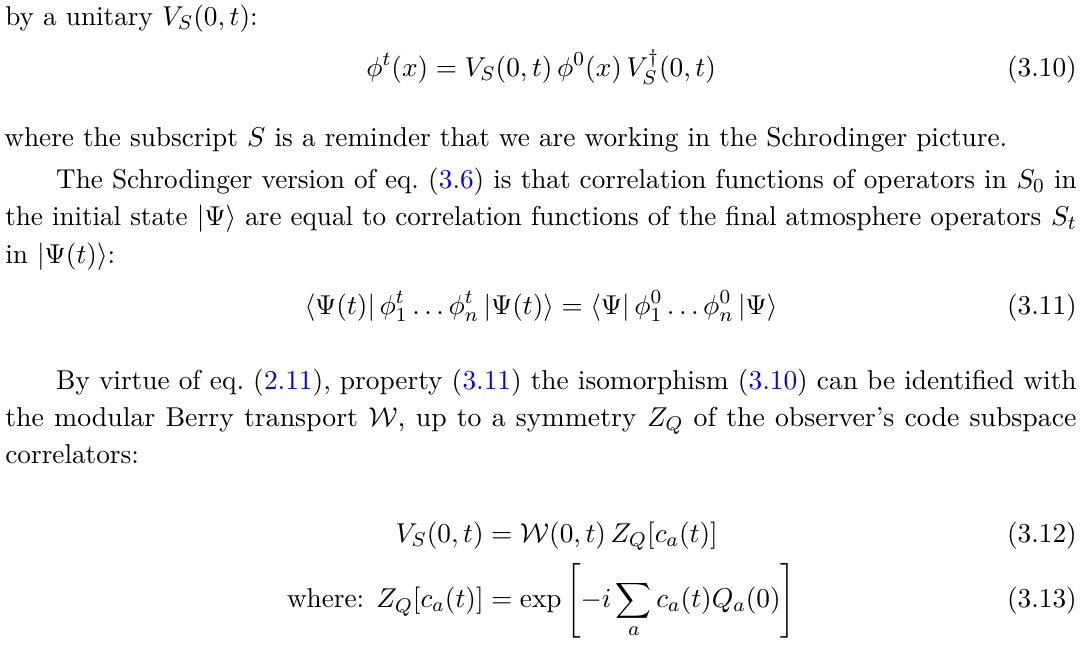
Figure 3. Illustration of the three different flows appearing in our discussion. H is the CFT Hamiltonian generating global AdS evolution. V is modular flow which maps the t H operators (green disk on t = 0 slice) to the Heisenberg picture atmosphere operators at t i describes the evolution of the atmosphere operators in the Schrodinger picture and captures the motion of the black hole relative to the